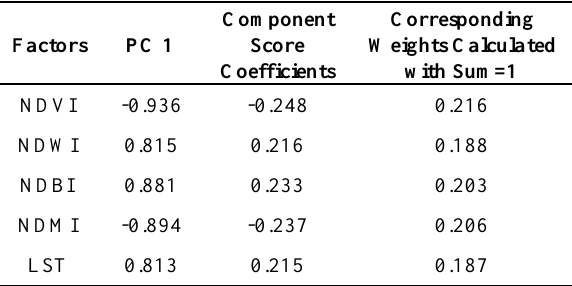
Table 5. Weightage of the factors using PC1 score